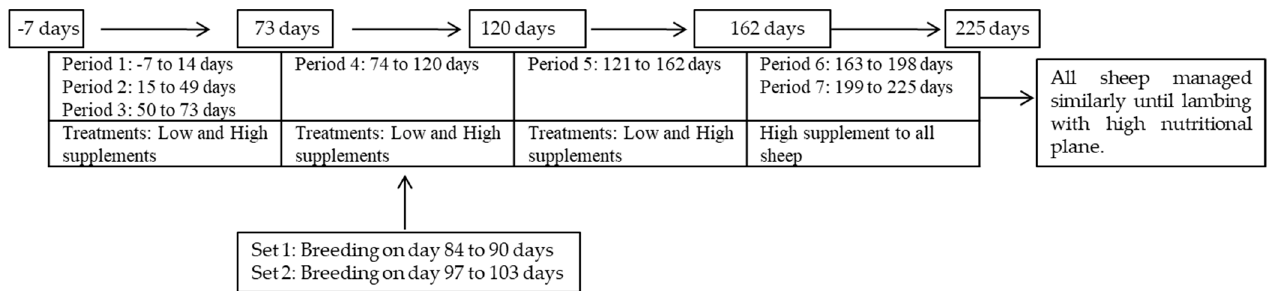
Figure 2. Two supplements fed to three breeds of sheep during different periods.